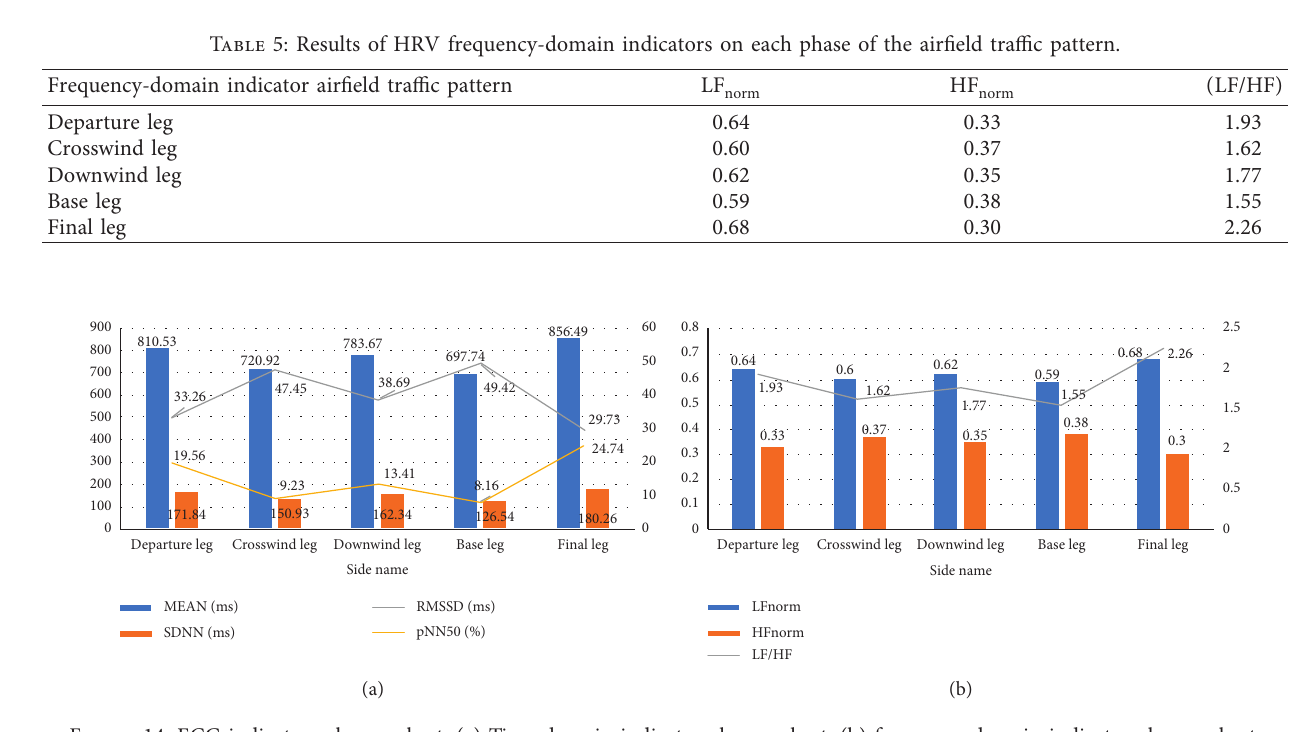
Figure 14: ECG indicators change chart. (a) Time-domain indicator change chart; (b) frequency-domain indicator change chart.